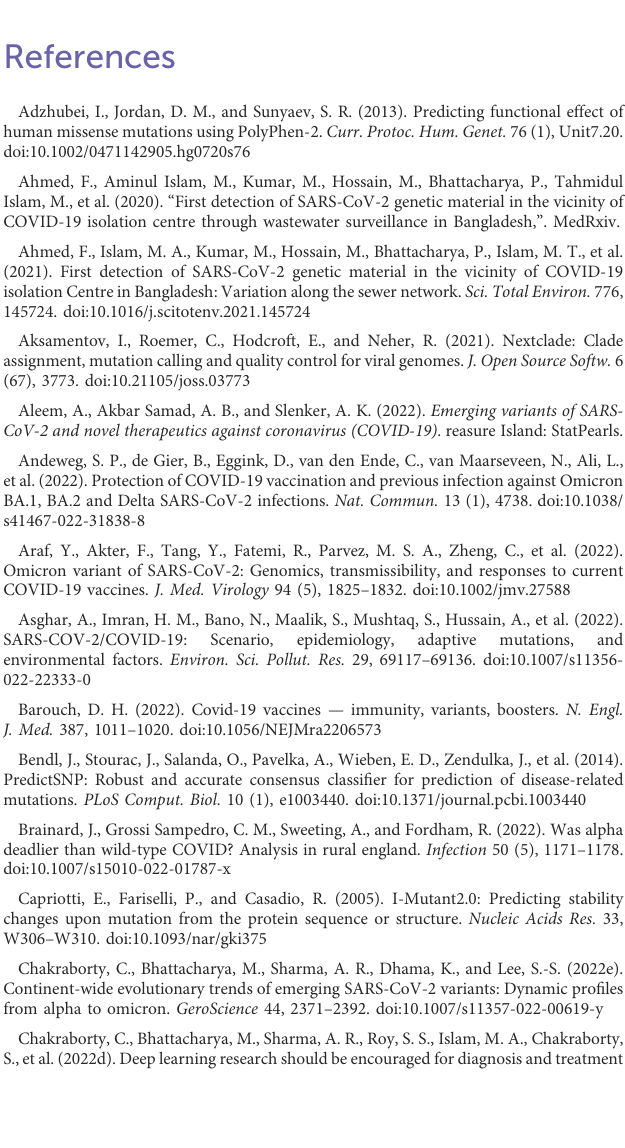
SUPPLEMENTARY TABLE S6 Effects of missense mutations on protein stability. SUPPLEMENTARY TABLE S7 Learning (left) and Testing (right) dataset for machine learning validation. SUPPLEMENTARY TABLE S8 All neutral and deleterious mutations for Delta and Omicron variant. SUPPLEMENTARY TABLE S9 All of the SARS-CoV-2 Whole Genome Sequences